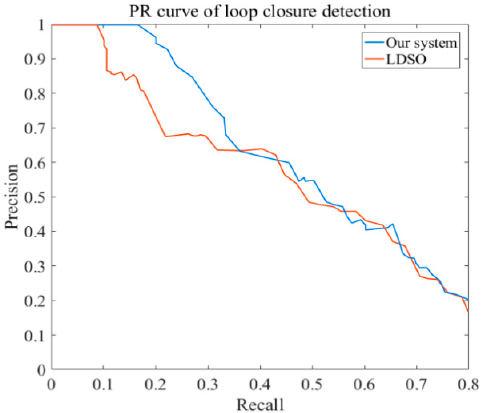
Figure 14. The contrast of precision-recall ratios between our system and LDSO on KITTI dataset.